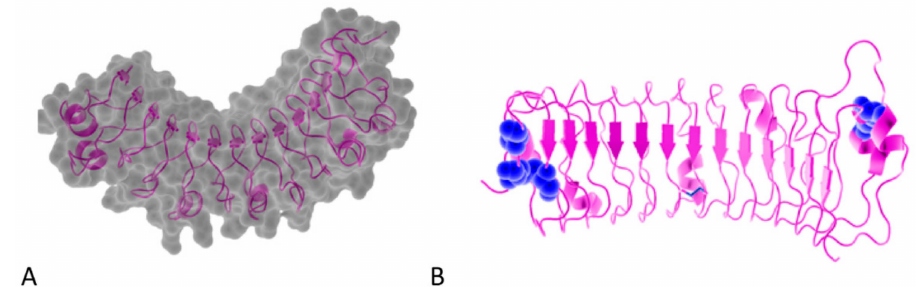
Figure 1. ( A ). Osteomodulin in 3D view (PDB id: 5YQ5) with PyMol showing the horseshoe shape with 13 β -sheets on the concave side and 13 α -helices on the convex side. ( B ). Osteomodulin in 3D view (PDB id: 5YQ5) with PyMol showing cystein residues (in blue) of the protein near the N-terminal (C66, C68–C78 on the left) and C-terminal end (C321–C353 on the right downstream of the ear-repeat). The secondary structure’s graphical representations showing the small leucine-rich proteoglycans (SLRPs) salient features were carried out with the PyMol software (PyMOL TM 2.3.1—Incentive Product Copyright Schrodinger, LLC) and using home-made Python scripts to display relevant amino acids in chosen